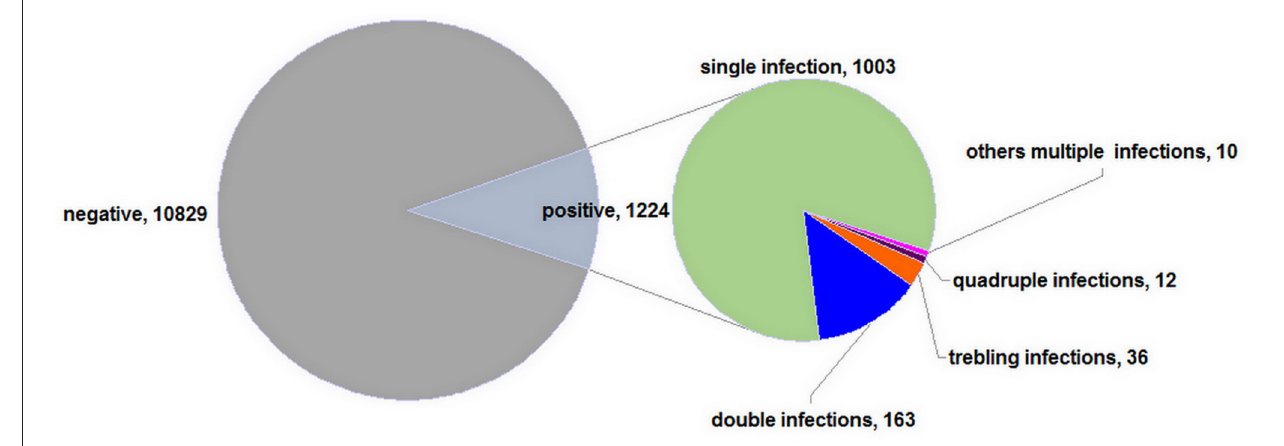
FIGURE 1 | Human papillomavirus (HPV) prevalence among 12,053 women.